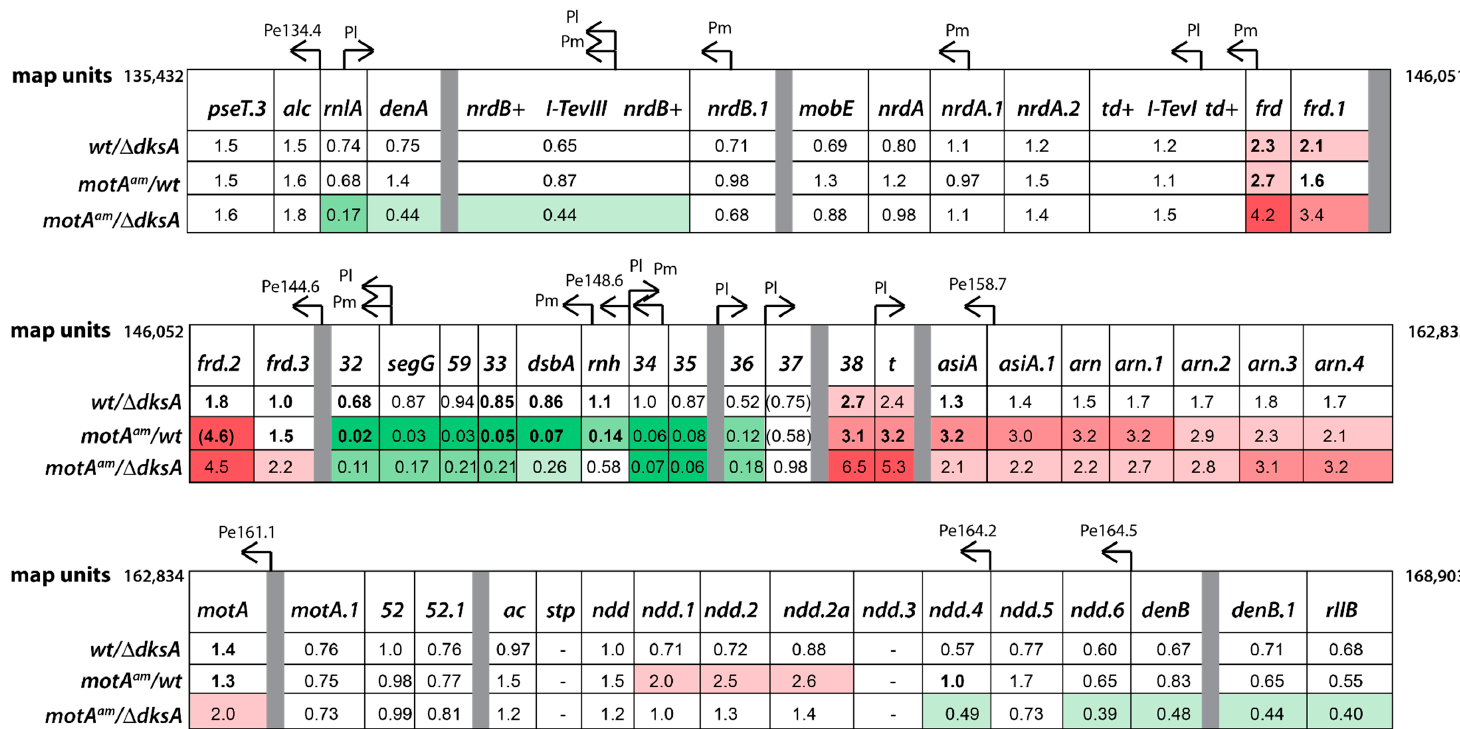
Figure 3. Genomic map of bacteriophage T4 correlated with gene expression data from RNA-seq. Graphical representation of the T4 genome showing the location of annotated genes and promoters as given in [53]. The fold changes from the RNA-seq analyses determined for infections of T4 wt/B606 dksA (wt/ dksA ), T4 motA am /B606 wt ( motA am / wt), and T4 motA am /B606 ∆ dksA ( motA am /dksA ) compared to T4 wt/B606 wt are indicated. Gene expression changes are color coded as: increasing expression ≥ 2.0 with increasing red intensity; no significant change, white; decreasing expression ≤ 0.5 with increasing green intensity. Values of genes whose expression was checked by real-time quantitative polymerase chain reaction (RT-qPCR) are given in bold; any value that was tested in RT-qPCR analyses but was not consistent is given in parenthesis. Genes without an indicated value had less than 50 mapped reads in all the RNA-seq data samples. The genomic coordinates (map units) for each region are listed at the start and end of that row of genes.